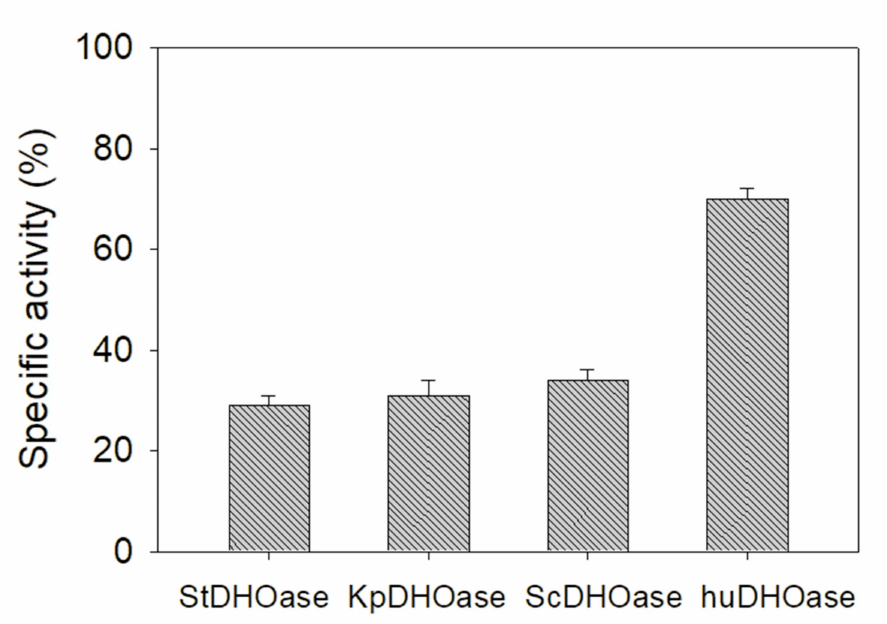
Figure 3. Inhibition specificity of PLU. PLU (200 µ M) decreased the activities by 71%, 69%, 66%, and 30%, respectively.